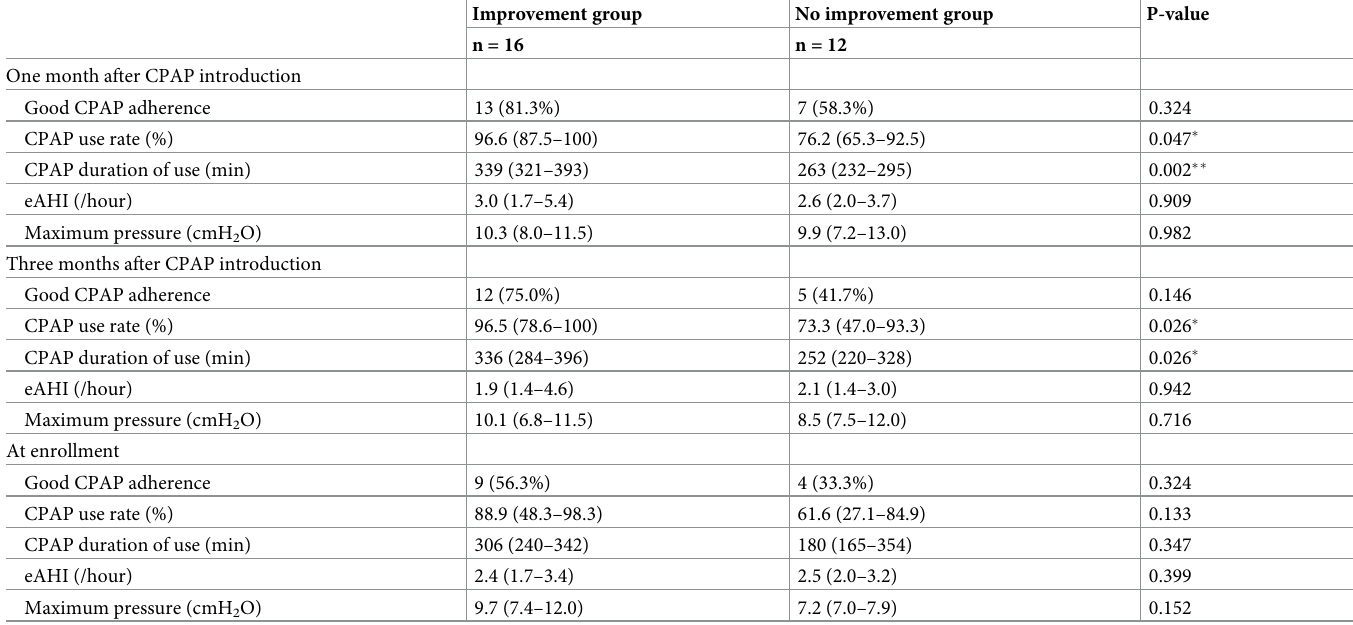
Table 5. Changes in CPAP data between the groups with and without persistent high rhinomanometry values (exhalation). Improvement